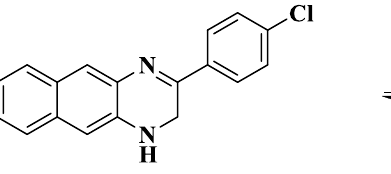
Figure 2. Two isomers of compound 2 .